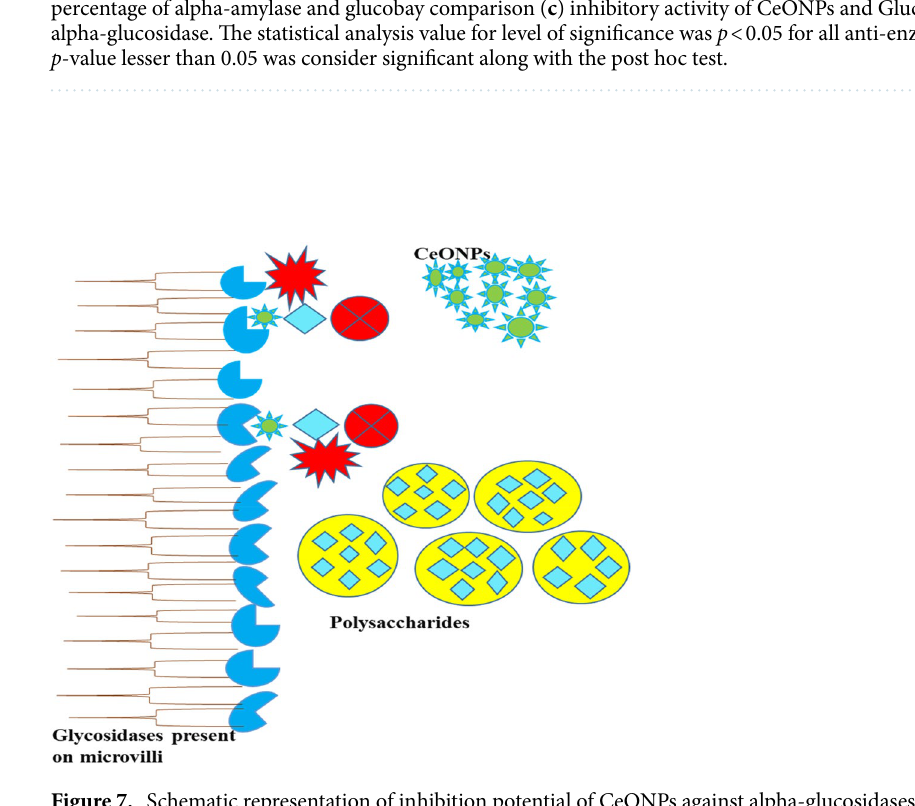
Figure 7. Schematic representation of inhibition potential of CeONPs against alpha-glucosidases. The alpha-glucosidase is naturally present in the microvilli in the small intestine and accelerates the breakdown of polysaccharides. CeONPs reduce the formation of the enzyme–substrate complex by covering the active site of the enzyme. The reduction of metabolic activity declines the release of glucose in the blood 12,12